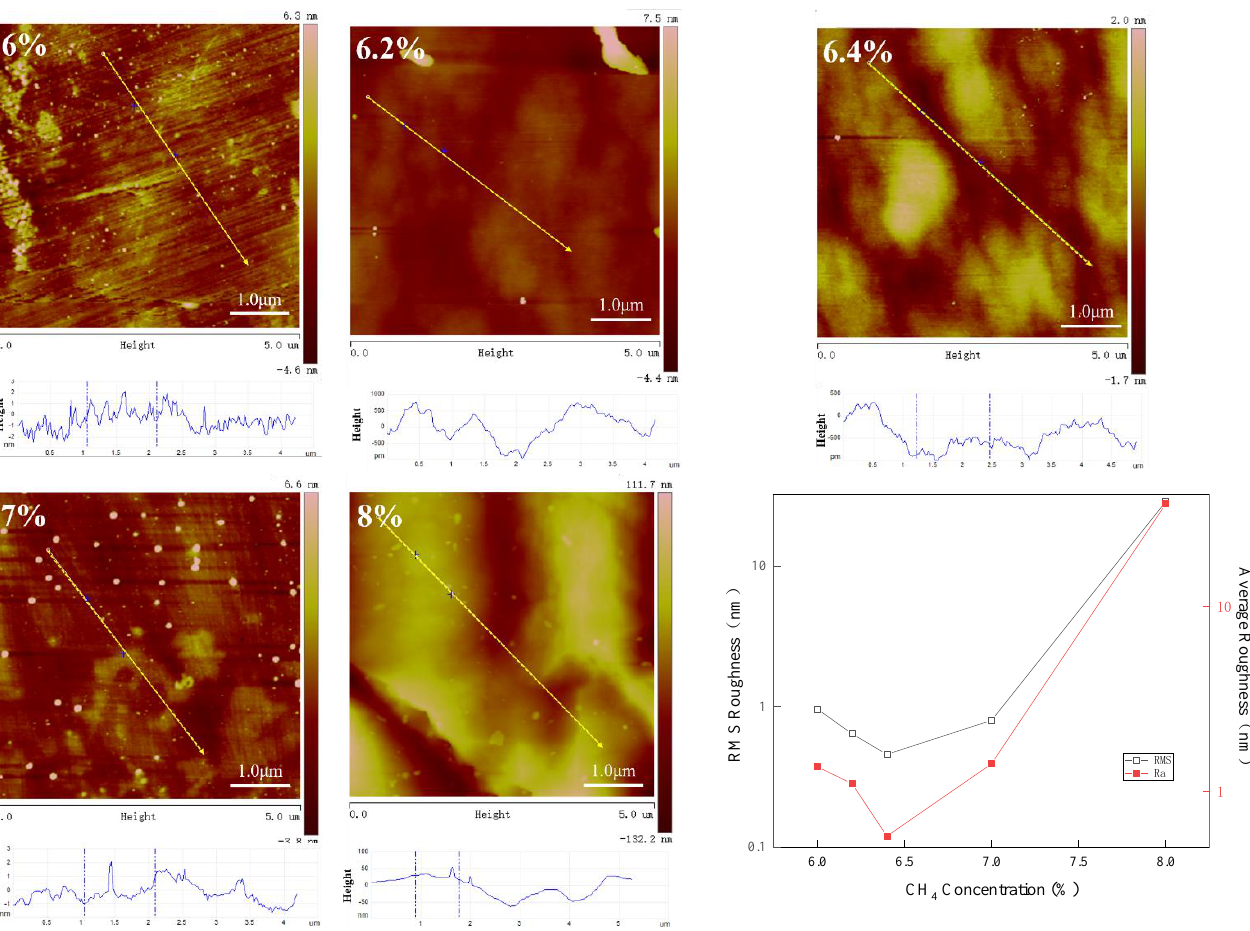
Figure 3. AFM two-dimensional images (the corresponding surface fluctuation along the yellow dashed) and the plot of the RMS, average roughness on the top surface of the diamond with different concentration of CH 4 .